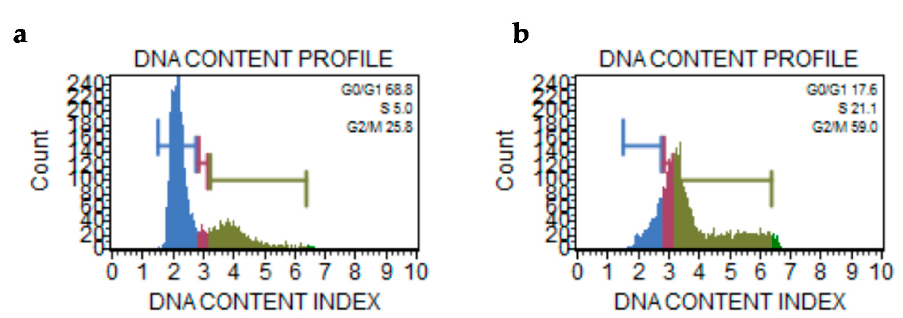
Figure 13. Cycle assay. ( a ) DNA content histogram of MDA-MB-231 cells treated with only DMSO; ( b ) DNA content histogram of MDA-MB-231 cells treated with AuL7 at the concentration corresponding to its IC 50 value for 72 h.